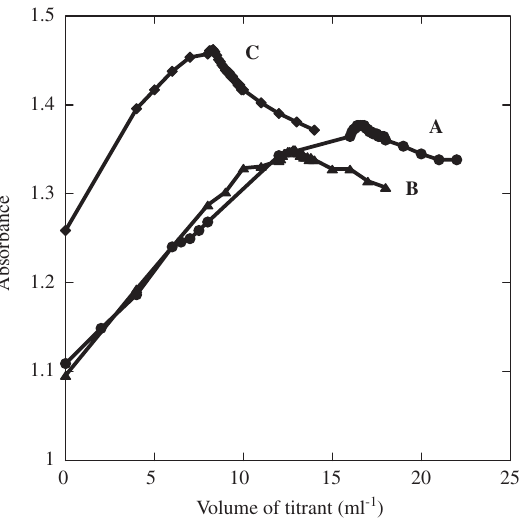
Figure 8 Photometric back titration curves for PHMB-HCl in a com- mercially available contact lens detergent A with a 1.0 × 10 -4 eq mol l